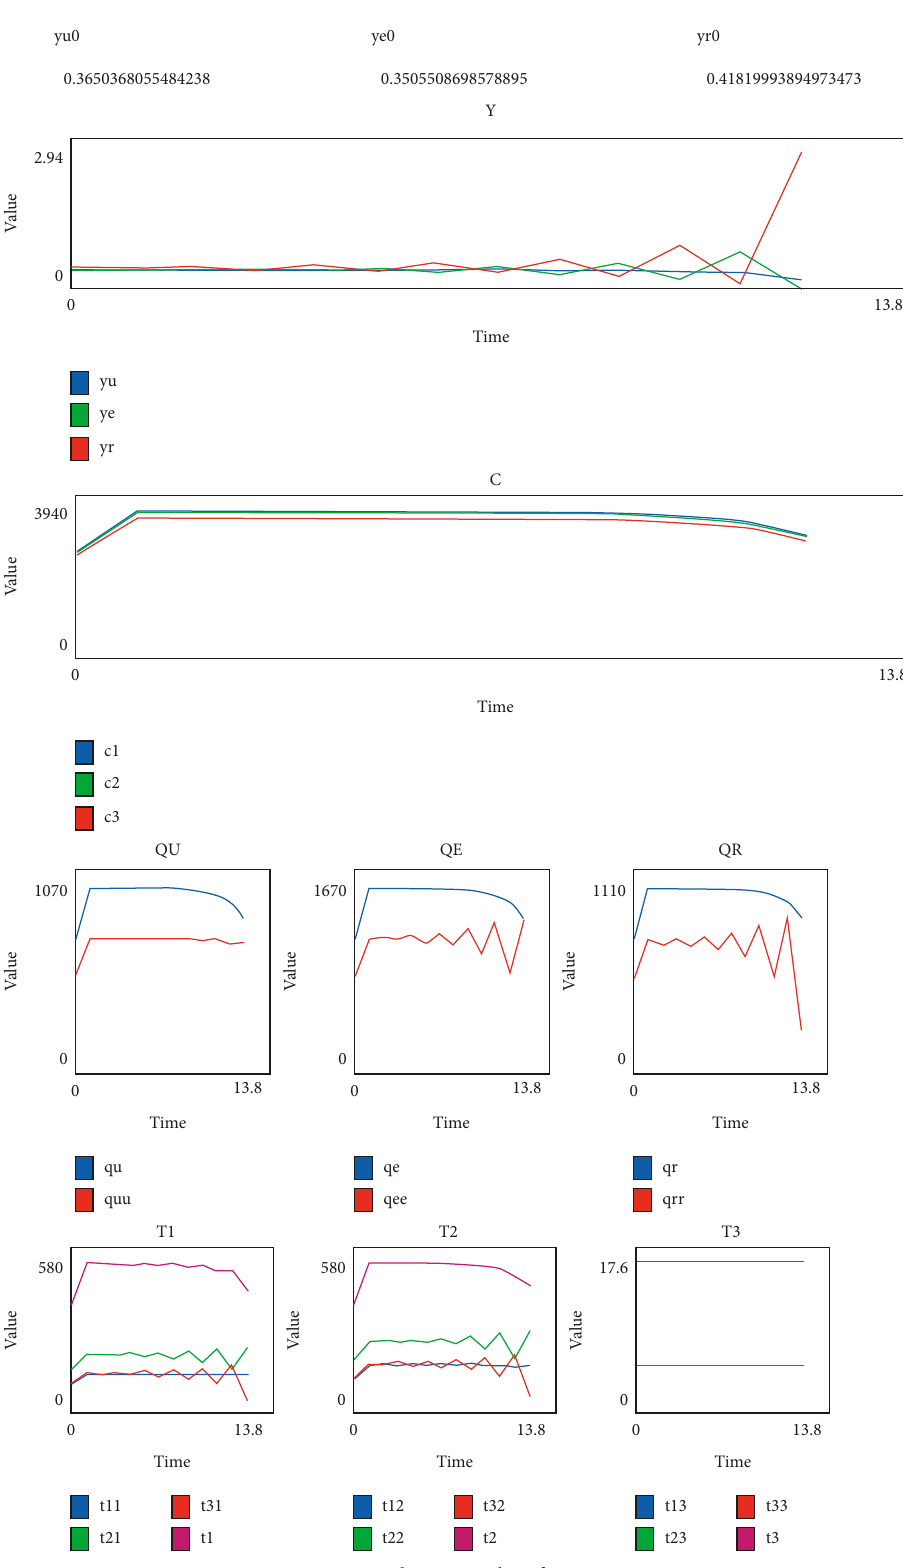
Figure 6: Simulation results of scenario